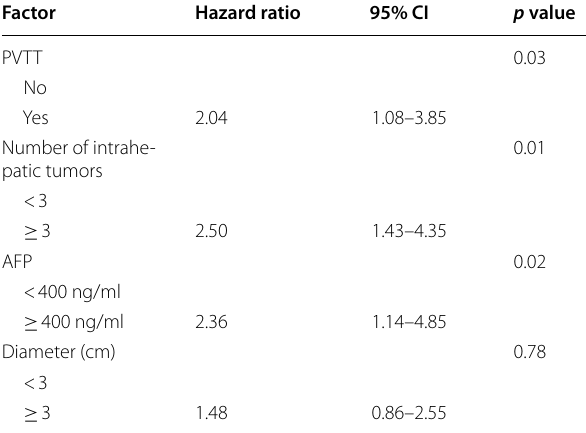
Table 3 Multivariate analysis of the risk factors of local tumor progression-free